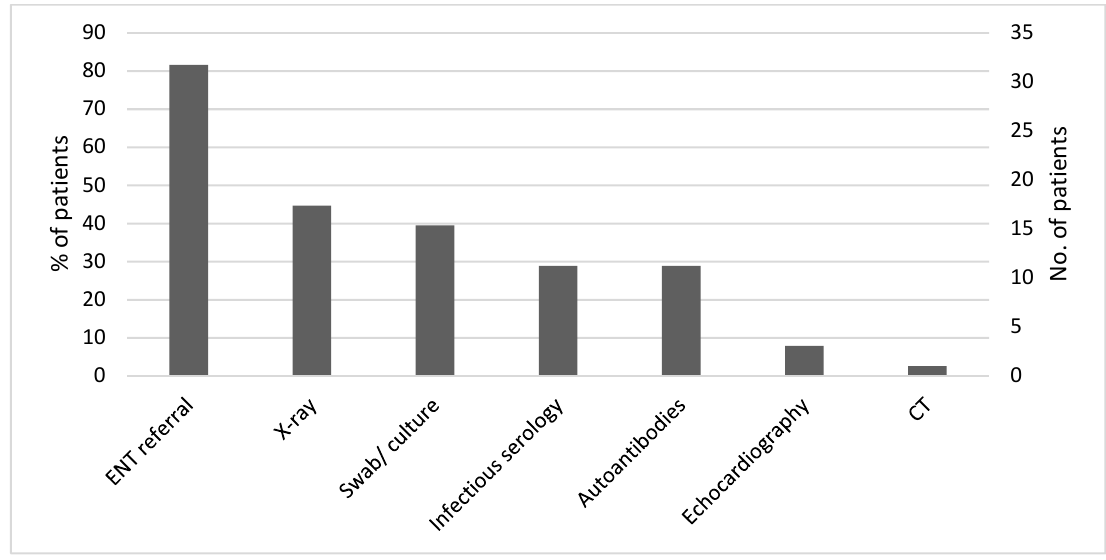
Figure 2. Investigations performed in search of an alternative diagnosis ( n = 38).